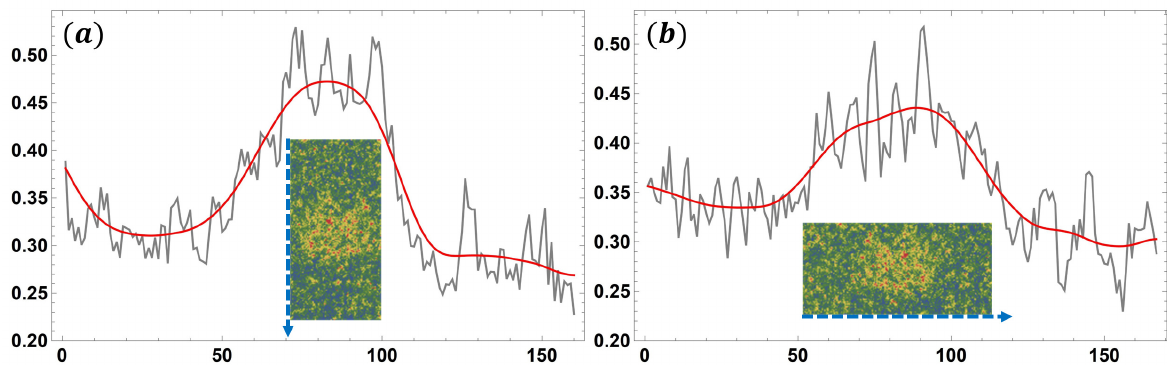
Figure 21. Neighborhood analysis for the reference spherical void, transmission along the longer axis with a extra distance to the scintillator: normalized width mean of luminance (gray) over the length of ( a ) horizontal and ( b ) vertical patches roughly fit to the sphere dimensions, spanning the cropped body